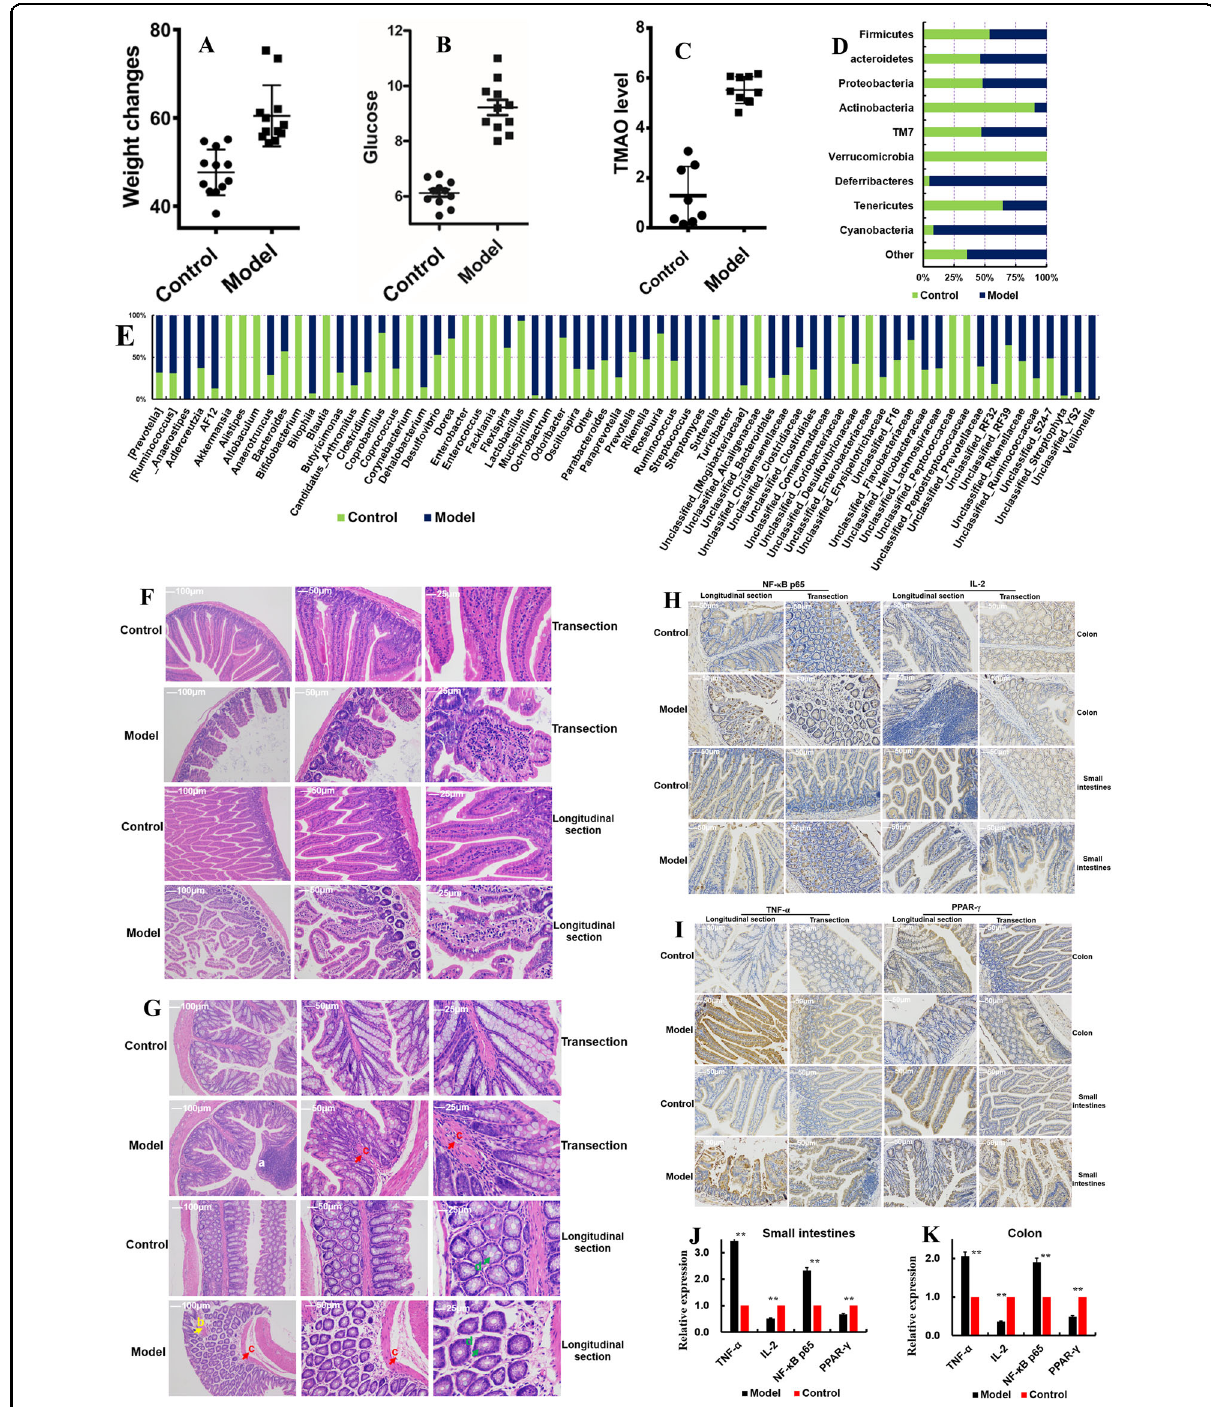
Fig. 1 Dysbacteriosis affects the homeostatic balance of the intestine in mice fed a diet high in sugar and fat for 4 months. A In fl uences of a diet high in sugar and fat on the bodyweight of mice. B In fl uences of a diet high in sugar and fat on the blood glucose level of mice. C In fl uences of a diet high in sugar and fat on TMAO levels in serum. D In fl uences of a diet high in sugar and fat on the gut microbiota at the phylum level. E In fl uences of a diet high in sugar and fat on the gut microbiota at the genus level, see Fig. S2. F , G In fl uences of a diet high in sugar and fat on intestine ( F ) and colon ( G ) histopathology using H&E staining, see the pathologic observations in other organs (livers, renal, spinal marrow, spleen, adipose and heart) in Fig. S2. H – K In fl uences of a diet high in sugar and fat on intestine and colon histopathology using immunohistochemical analyses. Data are the mean ± SD of more than 8 independent experiments (the histopathology data were the mean ± SD of more than 3 independent experiments). * p < 0.05 and ** p < 0.01 vs. the model group by one-way ANOVA, followed by the Holm – Sidak